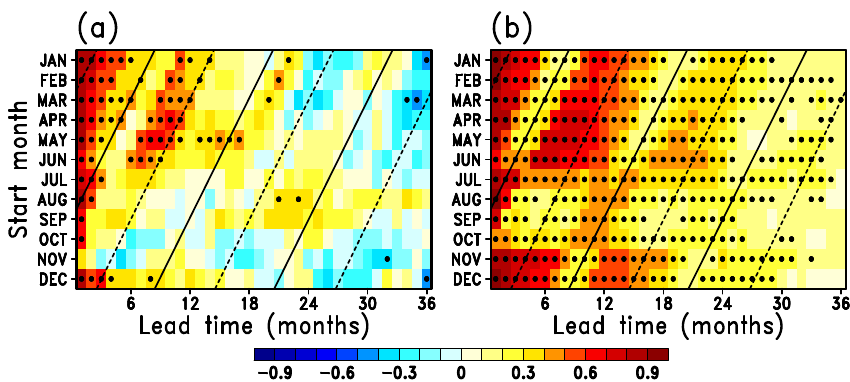
Figure 1. Lagged auto-correlation coefficients of the detrended SIE AO anomaly derived from (a) observations (Ishii et al., 2006; Ishii and Kimoto, 2009) and (b) a model control simulation, for each start month, against lead time, following Day et al. (2014b). Solid and dashed lines denote values for the September and March target months, respectively. Black dots indicate statistical significance at a 95% confidence level based on a two-sided Student’s t test with 30 and 200 degrees of freedom in the observations and model,